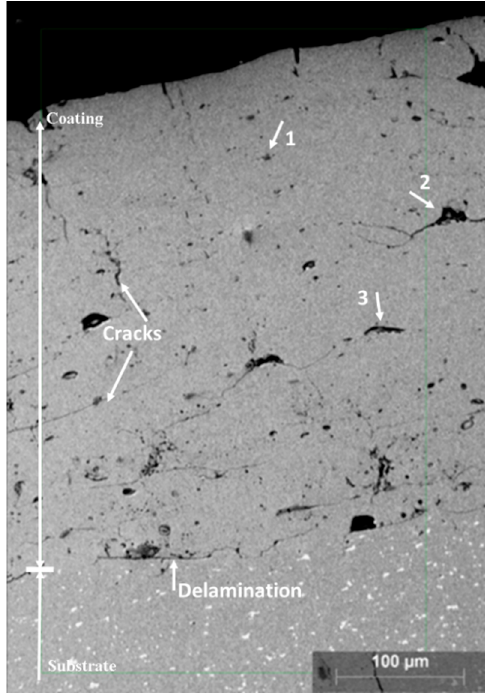
Figure 5. SEM image of multiple-layer deposit (cross-section) produced using 50 deposition passes and shield gas Ar: spherical voids (gas porosity n°1), large, random shaped voids (bridging porosity n°2) and thin void layers (laminar porosity